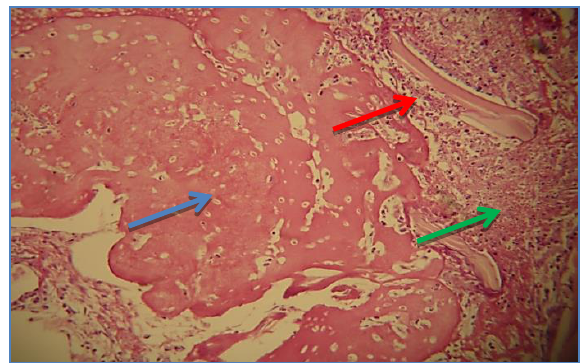
Figure, 7: Stomach of rabbit (G2),7th day p.o showing deposition of large amount of fibrin (blue arrow) with presence of remnant suture material (red arrow) with presence of large number of free RBCs (Green arrow) (H and E 40x ).